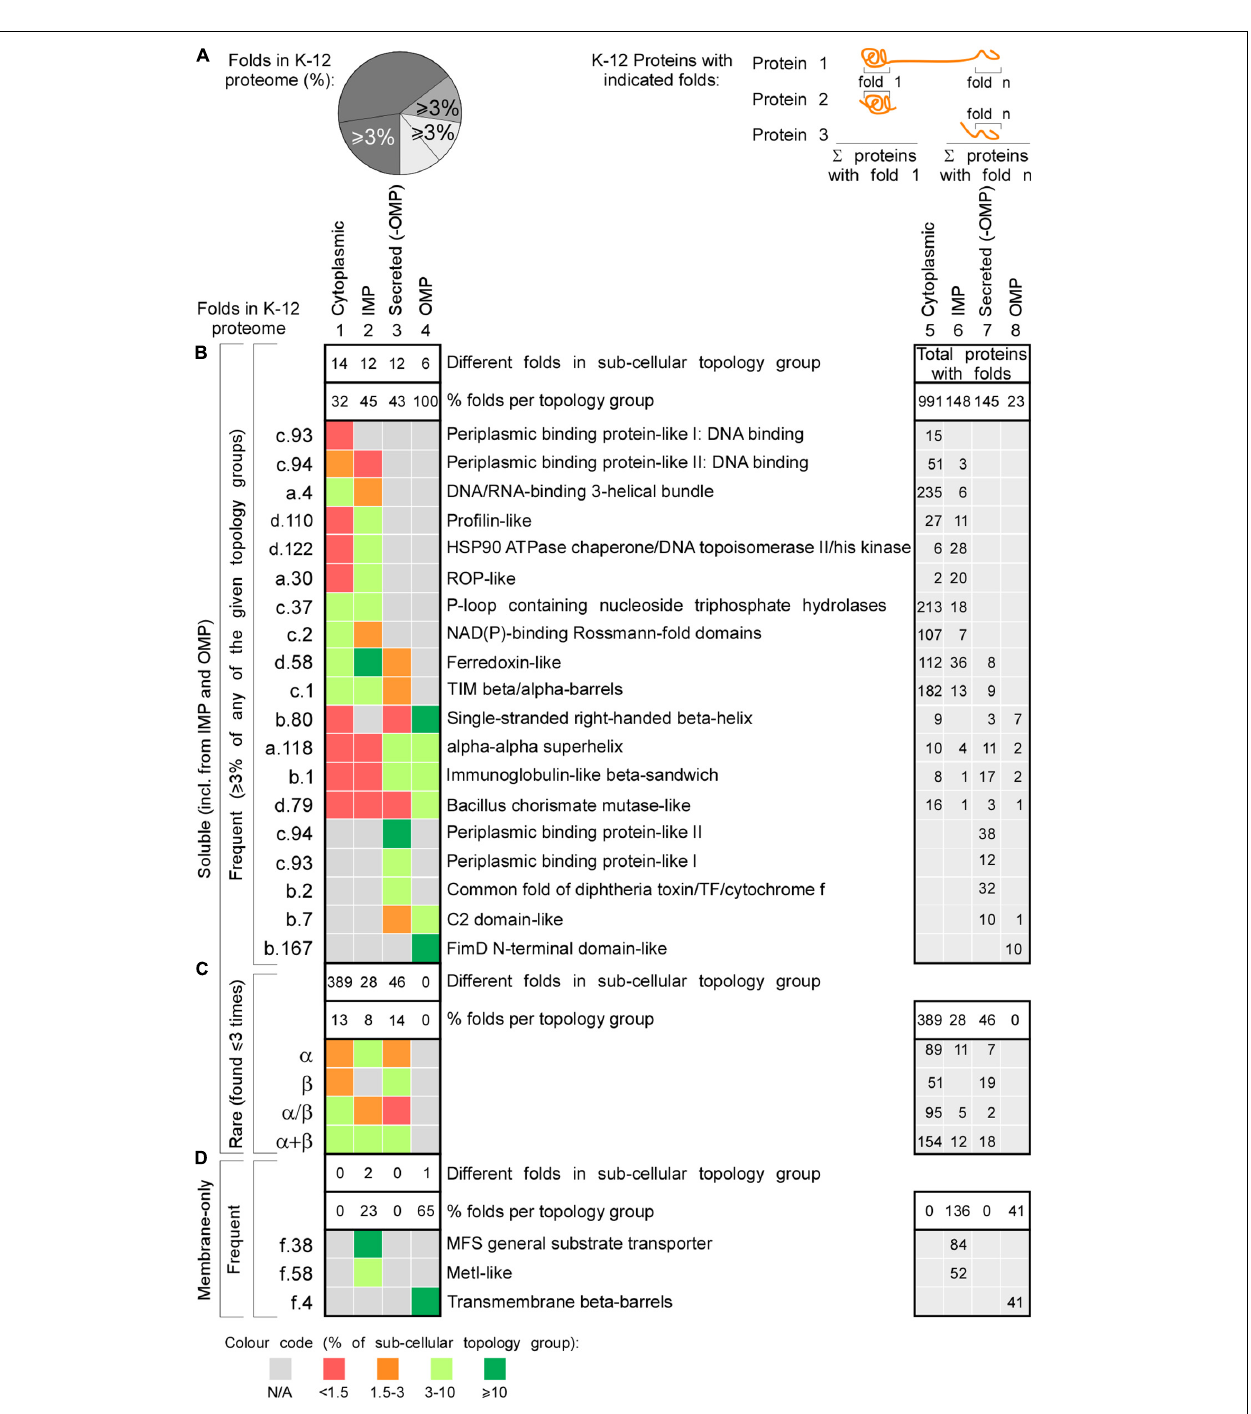
Frontiers in Microbiology |